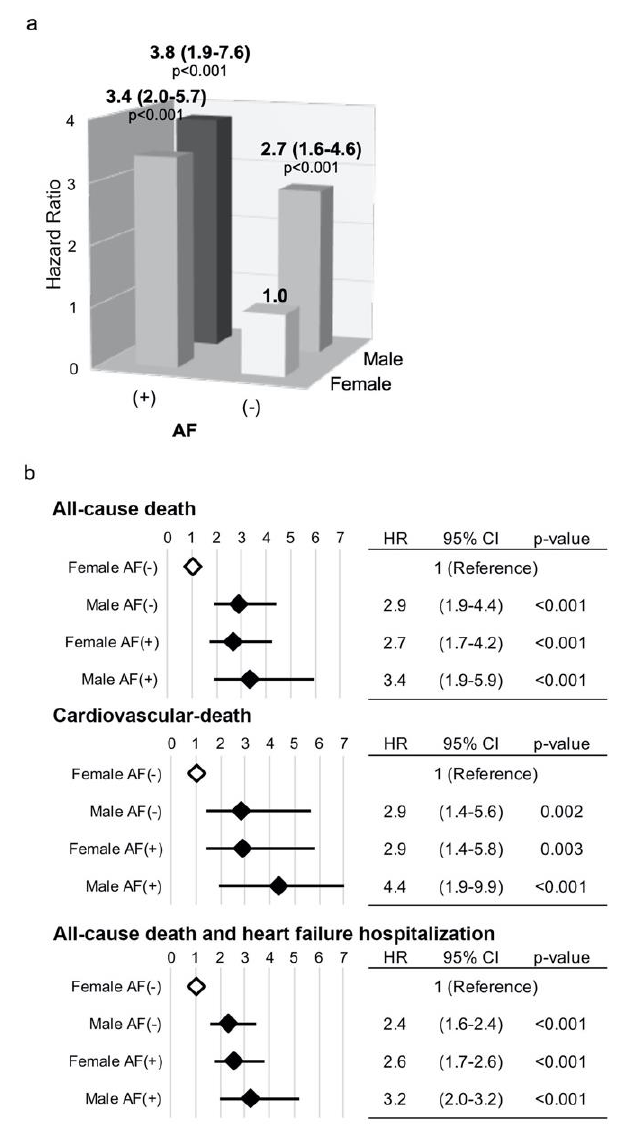
Figure 3. Hazard ratios for all-cause mortality in the 4 patient groups using Model 1 ( a ) and those for all-cause and cardiovascular mortalities and the composite of all-cause mortality and heart failure hospitalization using Model 2 ( b ). Hazard ratios, 95% confidence intervals (CI) and p-values for all-cause mortality following TAVI in the Female AF(-), Male AF(-), Female AF(+) and Male AF(+) groups calculated by Cox proportional hazard analysis using Model 1 ( a ) and Model 2 ( b ). Open and filled rhombus indicate reference, and significantly increased risk for each endpoint, respectively.